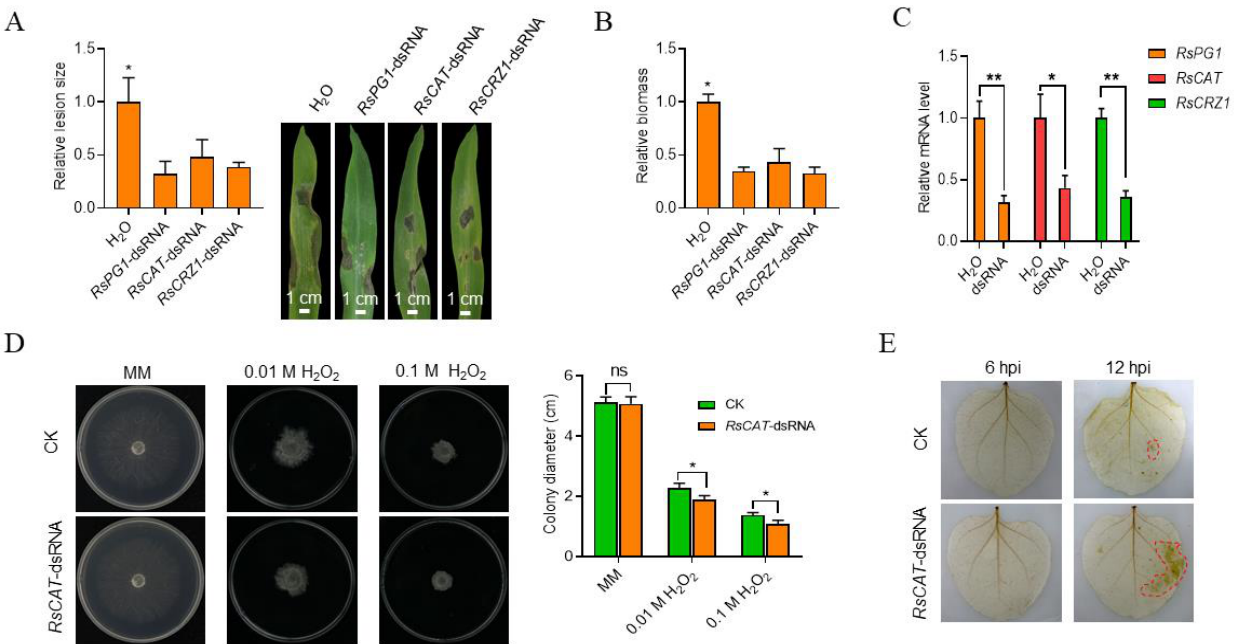
Figure 3. Exogenous spray of dsRNAs targeting pathogenic genes of R. solani significantly reduces its virulence. ( A ) Lesion sizes of maize leaves inoculated with R. solani mycelial blocks after treatment with dsRNAs targeting the RsPG1 , RsCAT, or RsCRZ1 gene. Lesion sizes were measured using ImageJ 3 dpi. ( B ) Biomass of R. solani in maize leaves 3 dpi. ( C ) Expression levels of the RsPG1 , RsCAT, and RsCRZ1 genes of R. solani 3 dpi in the maize leaves sprayed with different dsRNAs. ( D ) Sensitivity of R. solani treated with RsCAT -dsRNA to different concentrations of H 2 O 2 . CK, control; MM, minimal medium. ( E ) ROS content in the tobacco leaves sprayed with RsCAT -dsRNA. Leaves were taken at 6 HPI and 12 HPI with the pathogen and stained with DAB. ns, no significant differences; *, p < 0.05; **, p <